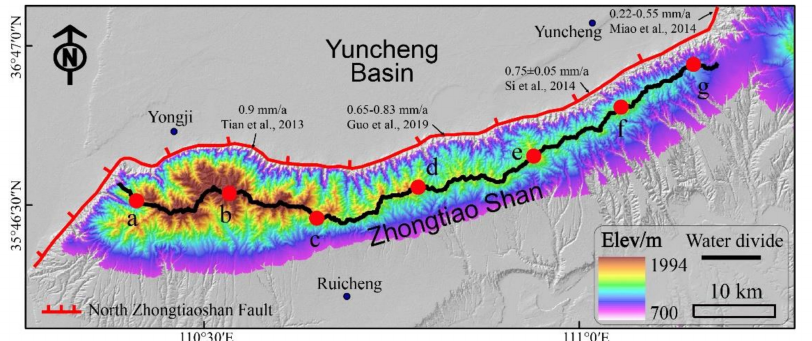
Figure 3. The main divide of the Zhongtiao Shan. The main divide was divided into six parts, namely, the ab, bc, cd, de, ef, and fg segments. The stability of each part was analyzed. The numbers along the fault indicate that slip rates of di ff erent segments of the fault